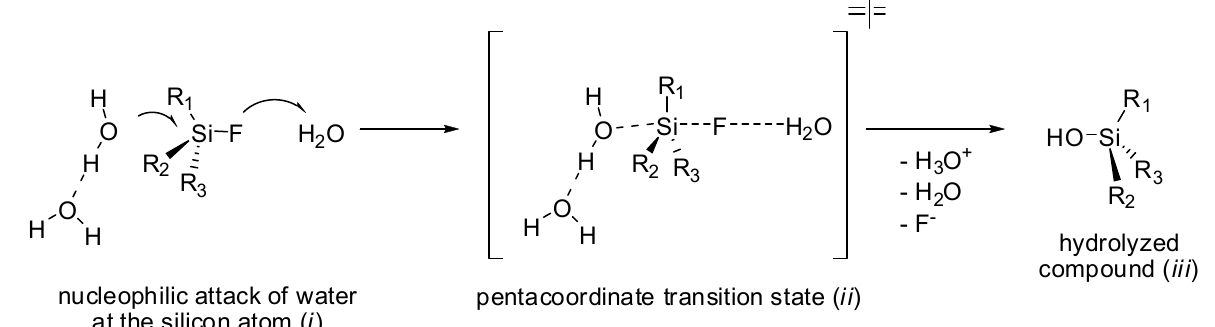
Figure 8. S 2 mechanism of Si-F bond hydrolysis with the common pentacoordinate N transition state ( ii ) as described in the literature. According to Ametamey and co-workers, water is a spectator in this